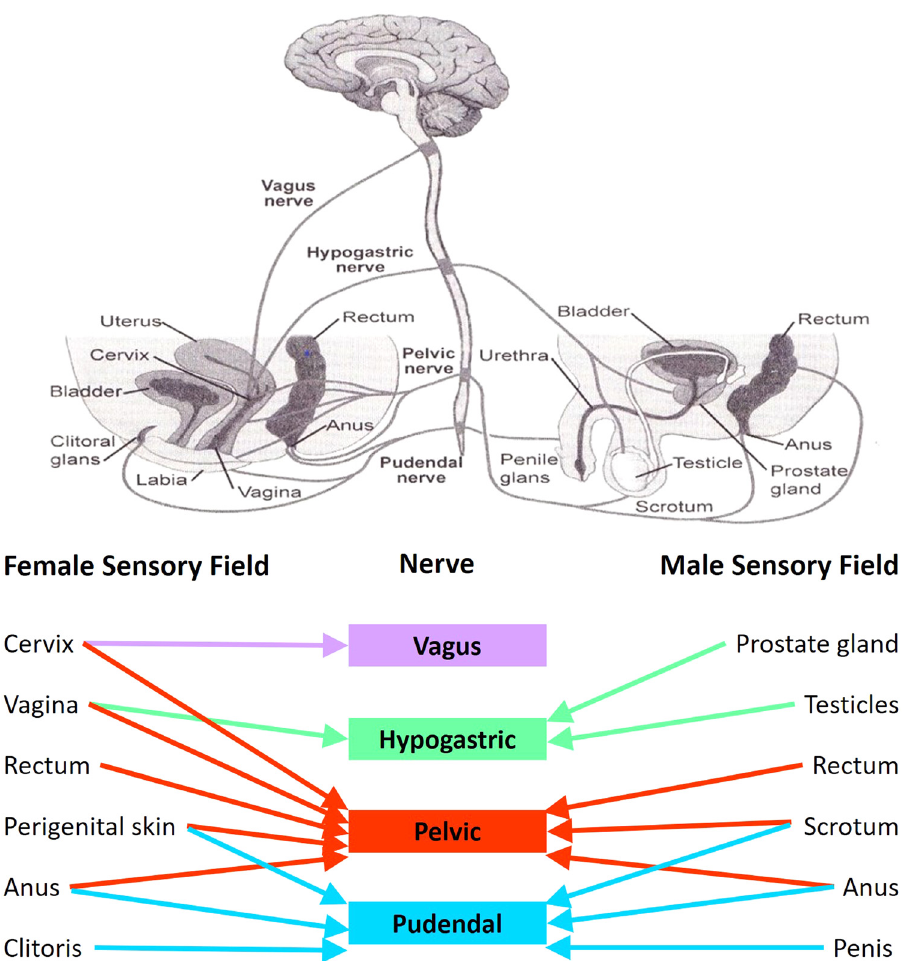
Figure 2: The organization of the sensory nerves innervating the pelvic region © 2017 Joan M. K. Tycko, Illustrator [ 18, p. 10 ]